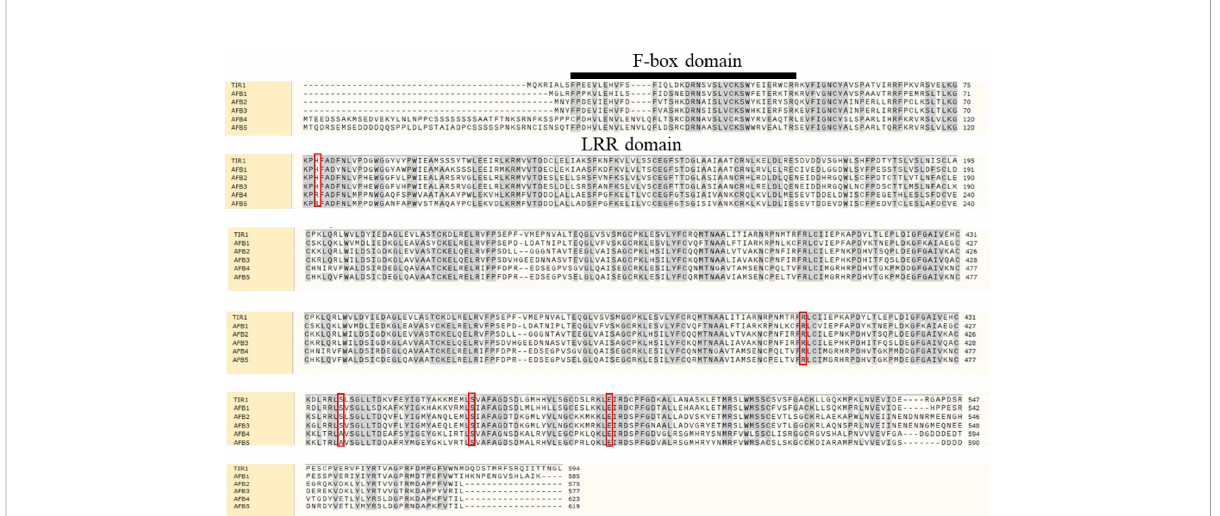
FIGURE 2 Multiple alignment of TIR1/AFB proteins in Arabidopsis adapted from Fu Guo et al. (Guo et al., 2021). Residues highlighted in gray are present in more than 50% of aligned sequences. The key residues making up the active site of the TIR1 pocket are highlighted by red boxes. Accession numbers of the genes encoding the proteins for the sequence alignment are as follows: TIR1 ( At3g62980 ), AFB1 ( At4g03190 ), AFB2 ( At3g26810 ), AFB3 ( At1g12820 ), AFB4 ( At4g24390 ), and AFB5 ( At5g49980